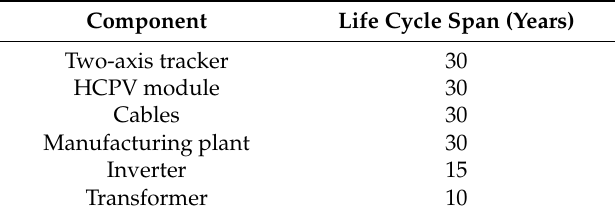
Table A5. Life cycle expectancies of HCPV system